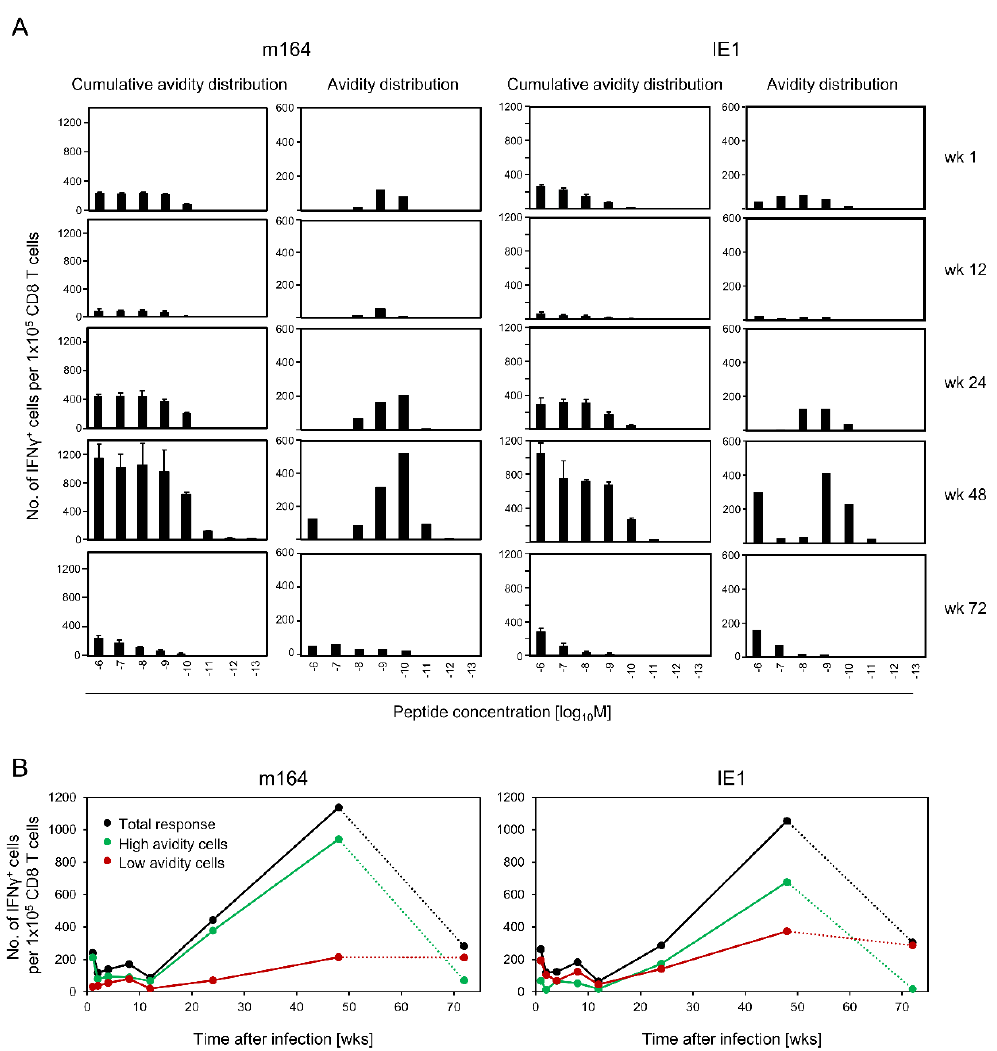
Figure 7. Kinetics of m164- and IE1-epitope-specific functional avidity patterns. ( A )